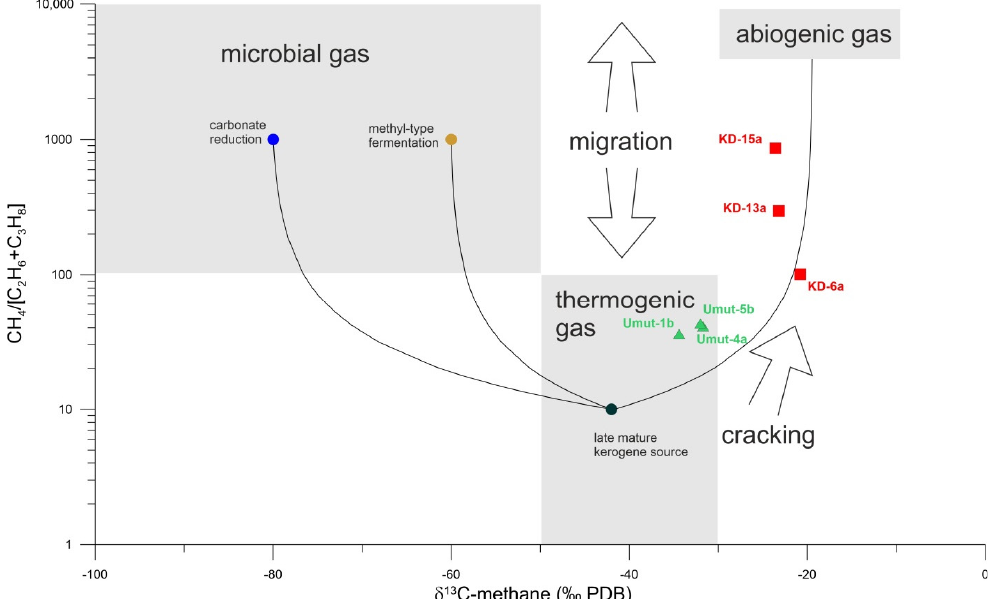
Figure 3. CH 4 /[C 2 H 6 + C 3 H 8 ] vs. δ 13 C diagram (“Bernhard-diagram”) including mixing lines of hydrocarbons from late mature kerogene source (black circle) with microbial gas from carbonate reduction (blue circle) and methyl-type fermentation (brown circle, values from [67]), as well as mixing with abiogenic hydrocarbons. Tekke Hamam samples plot in the thermogenic field, but